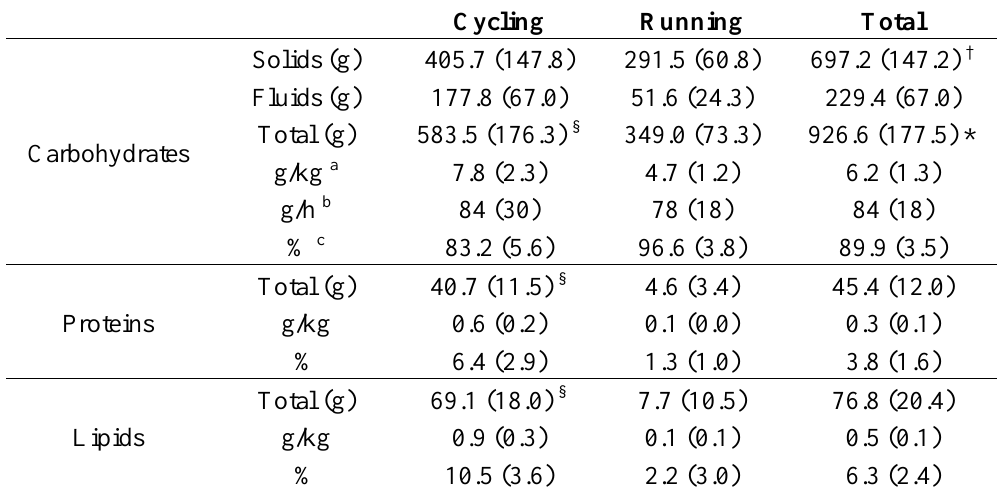
Table 3. Macronutrient intake during the ultra-endurance triathlon race.